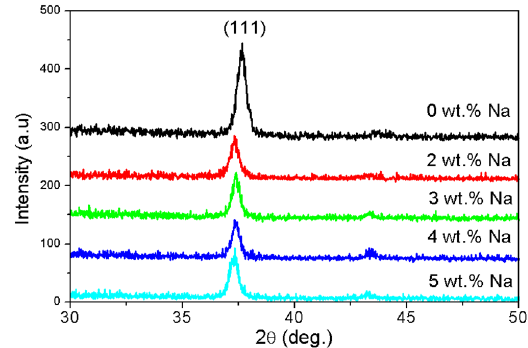
Figure 1. X-ray diffraction spectra of Na doped NiO thin films with various doping levels. Table 1. The measurements of Bragg angle 2θ, the full width at half-maximum FWHM, the crystallite size G , lattice parameter a and - a of (111) diffraction peak for Na doped NiO thin films with doping level. a 0 Na Doping (wt.%)